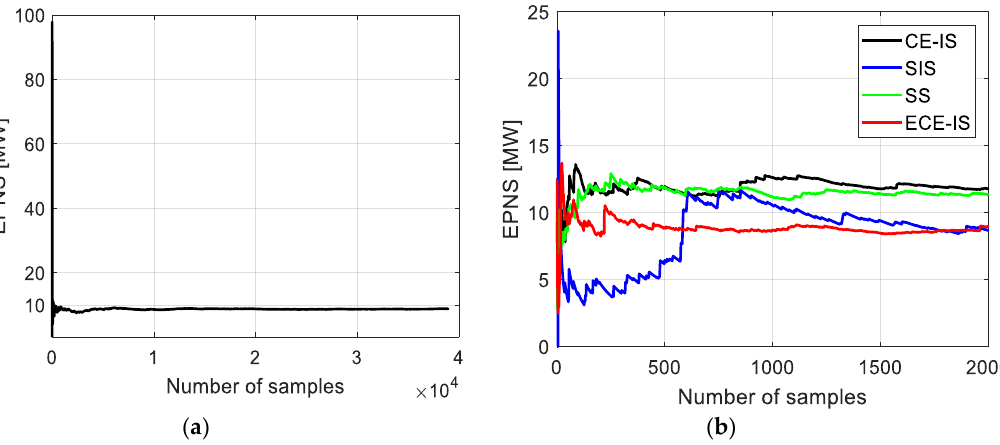
Figure 11. ( a ) System LOLP convergence in case of using standard MCS method; ( b ) system LOLP convergence in case of using CE-IS, SIS, SS, and ECE-IS approaches.